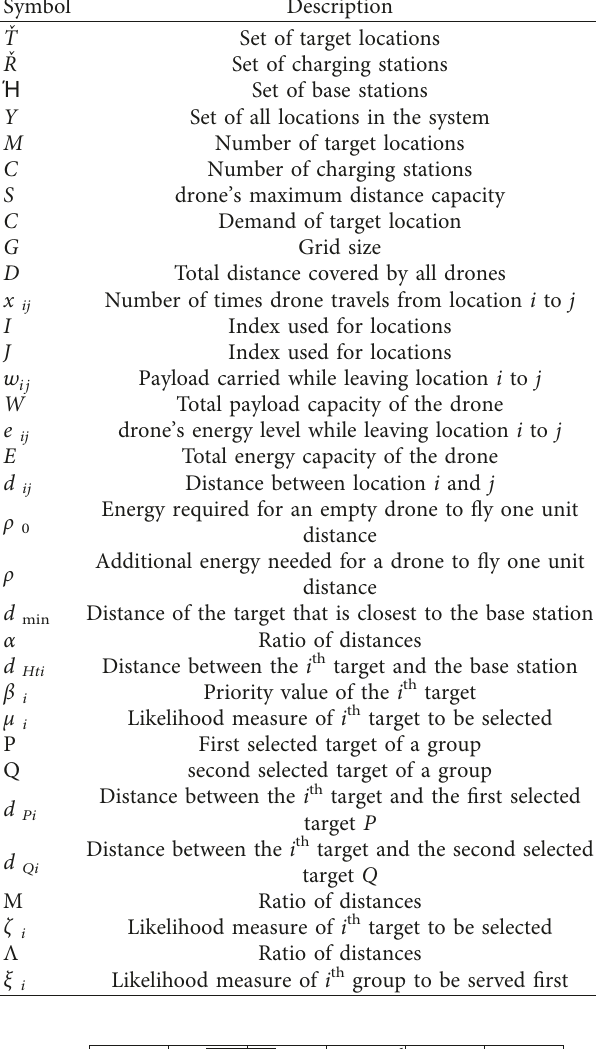
Table 2: Symbols and abbreviations.